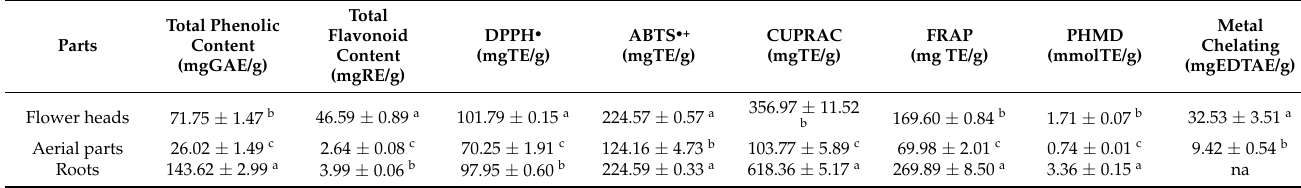
Table 2. Total bioactive compounds and antioxidant properties of Cirsium appendiculatum extracts